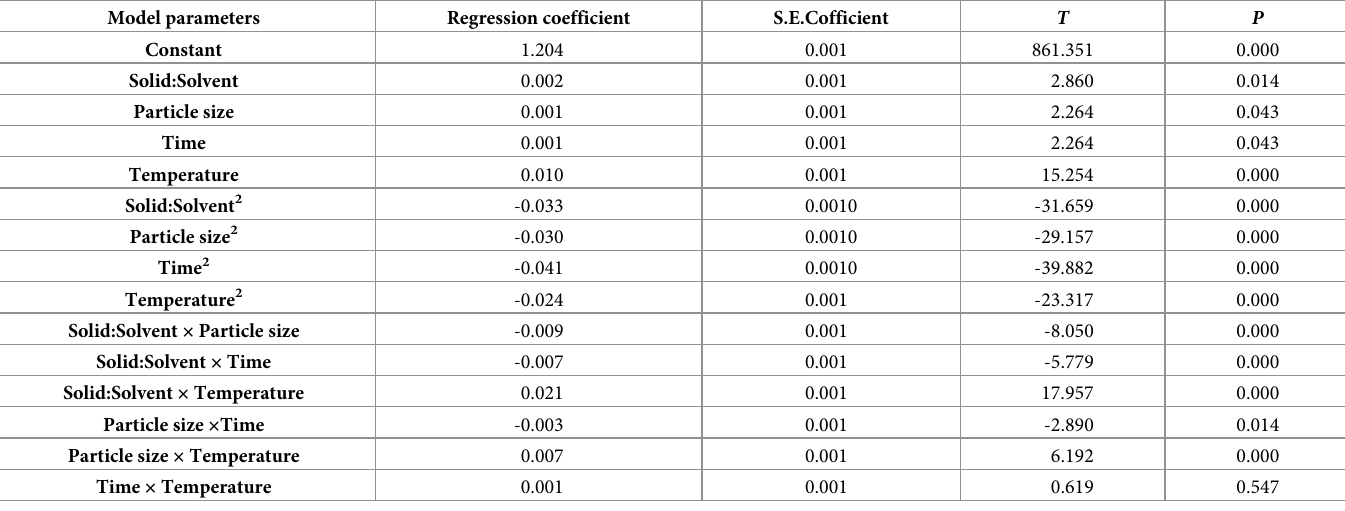
Table 7. Regression analysis of BBD criterion data for diosgenin extraction from D . deltoidea tuber. Model